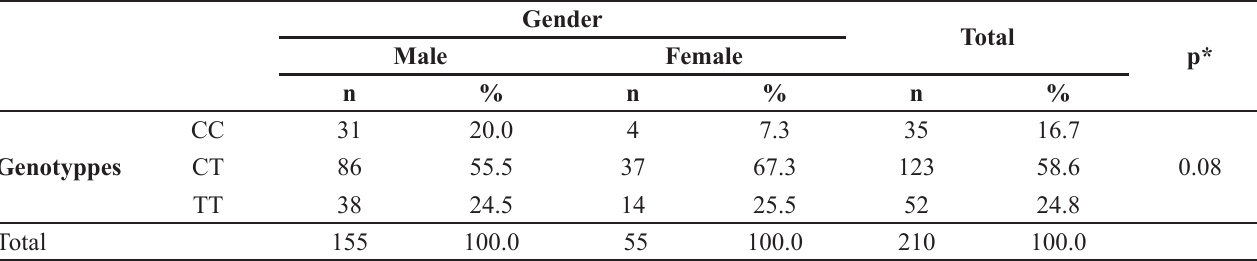
TABLE II - The MDR-1 C3435T gene distribution according to gender in each